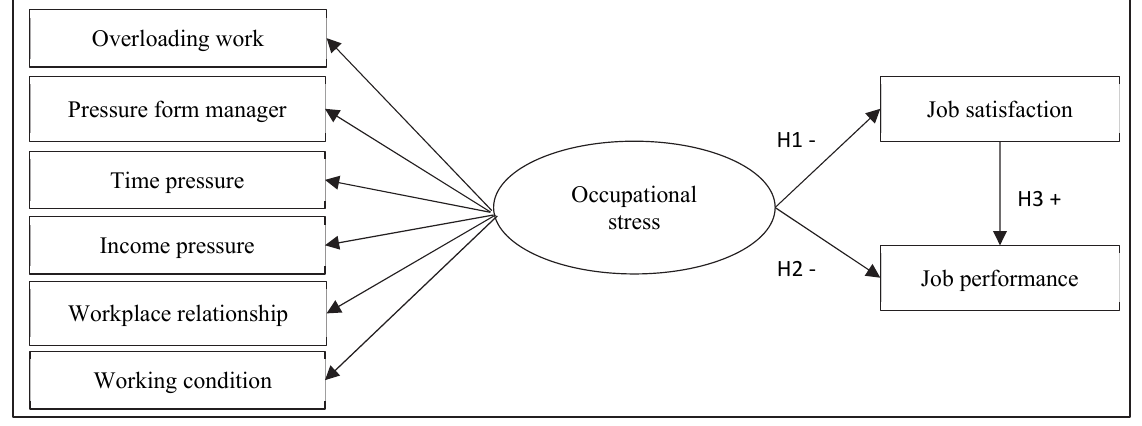
Fig.1. The proposed